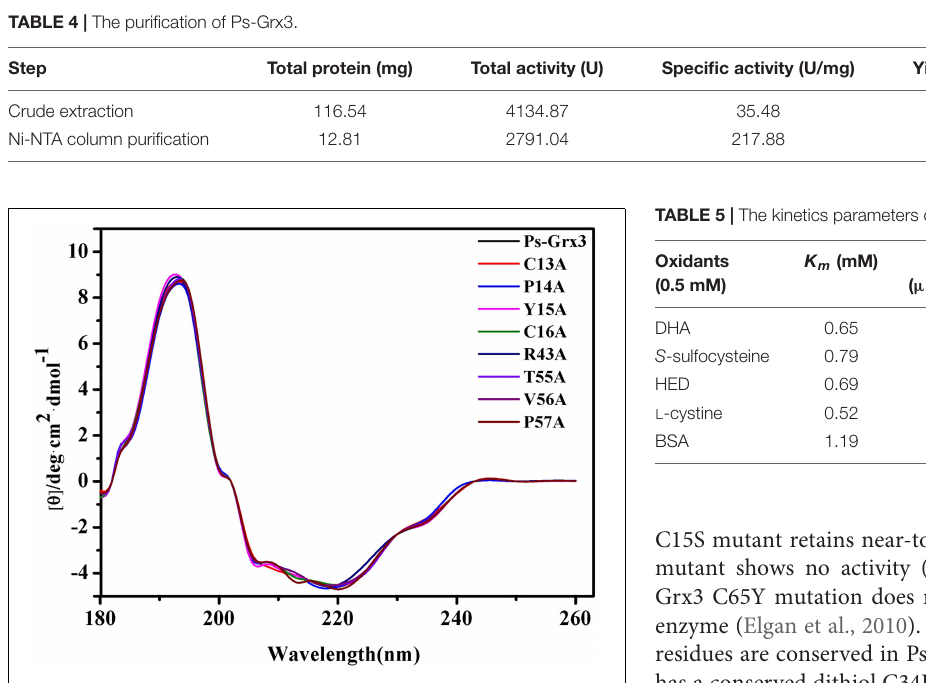
and lowest binding energy values for the interaction between GSH and Ps-Grx3 or EcGrx3 were determined to be − 4.9 and − 4.4 kcal/mol, respectively, for Ps-Grx3; and − 5.0 and − 4.4 kcal/mol, respectively, for EcGrx3. This indicated that Ps- Grx3 and EcGrx3 had similar affinities for GSH.